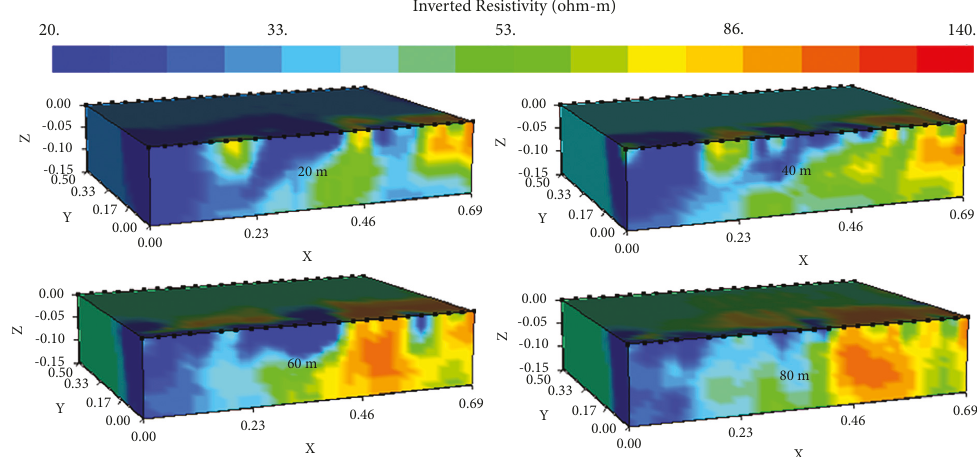
Figure 15: Three-dimensional resistivity inversion map of strata at 15cm above the coal seam. 35.